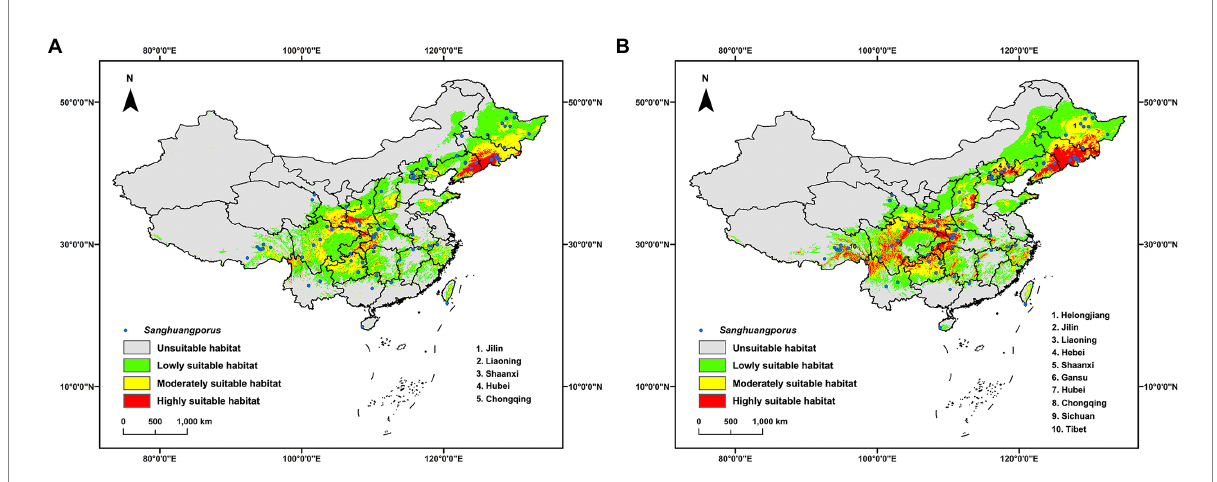
FIGURE 2 Current geographic distribution models of Sanghuangporus in China with the inclusion of host plant in the environmental variables (A) or not (B) . The known occurrence records are labeled as blue